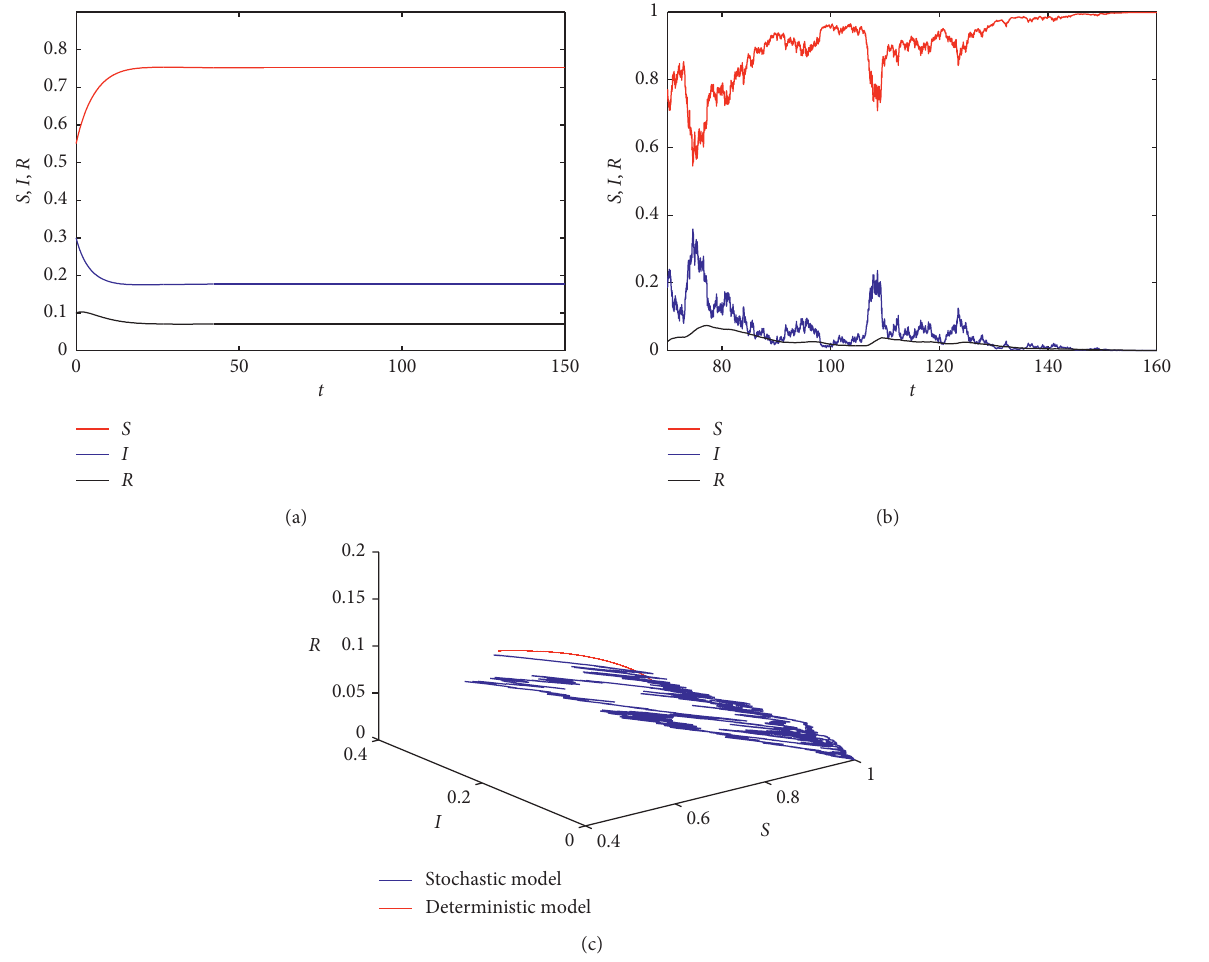
Figure 3: (a) Deterministic system, (b) corresponding stochastic systems of (a), and (c) the phase portrait of (b). (a) σ � 0 . 95 , σ � 0 . σ 1 2